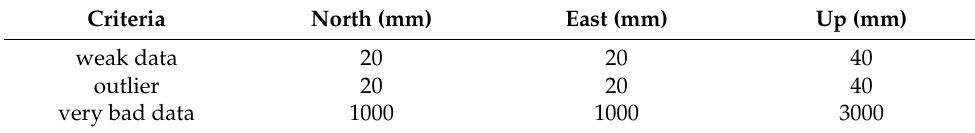
Table 2. Default criteria of the